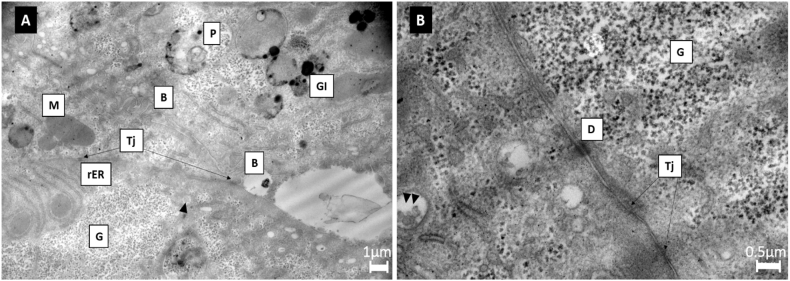
Ultrastructural feature of the spheroids by transmission electron microscopy (TEM). (A) shows a 5000-cell spheroid at day 3 of culture. TEM images showed characteristic hepatic ultrastructures. The presence of both glycogen vesicles (Gl) and granular glycogen (G) was abundantly expressed, as well as bile canaliculi (B) forming throughout the spheroid. The spheroids displayed a large quantity of metabolism-related organelles; including mitochondria (M), rough endoplasmic reticulum (rER), peroxisomes (P), and evidence of endocytosis or exocytosis (indicated by black arrow). There was also presence of tight junctions (Tj), indicating hepatic cell-cell interaction throughout the spheroid. (B) Ultrastructural features of the spheroids by transmission electron microscopy (TEM), day 7 of culture. TEM images displayed presence of glycogen (G), desmosomes (D) and specialised intracellular adherent junctions (Tj). Scale bar = 1 μm and 0.5 μm respectively.